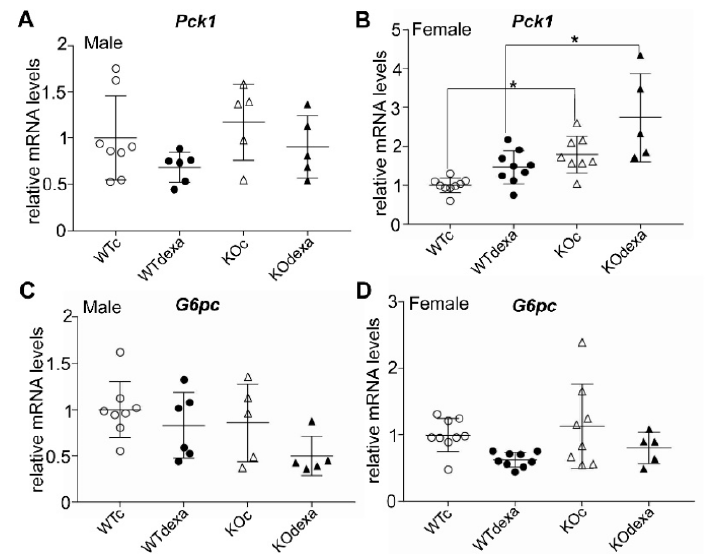
Figure 5. Relative mRNA expression of Pck1 and G6pc in liver of male ( A , C , respectively) and female ( B , D respectively) WT or Nrf2 KO mice treated with vehicle or dexamethasone. * p < 0.05 of the indicated comparison. WTc: wild-type control (vehicle-treated); KOc: Nrf2 knockout control (vehicle- treated); WTdexa: wild-type dexamethasone-treated; KOdexa: Nrf2 knockout dexamethasone